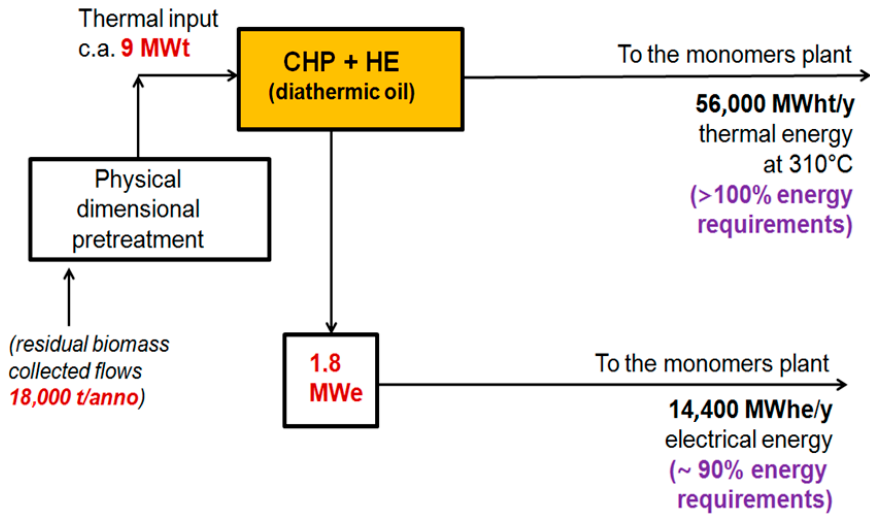
Figure 3. SCENARIO 2 ‐ Energy recovery from the residual biomass ( cardoon and carthamus ).